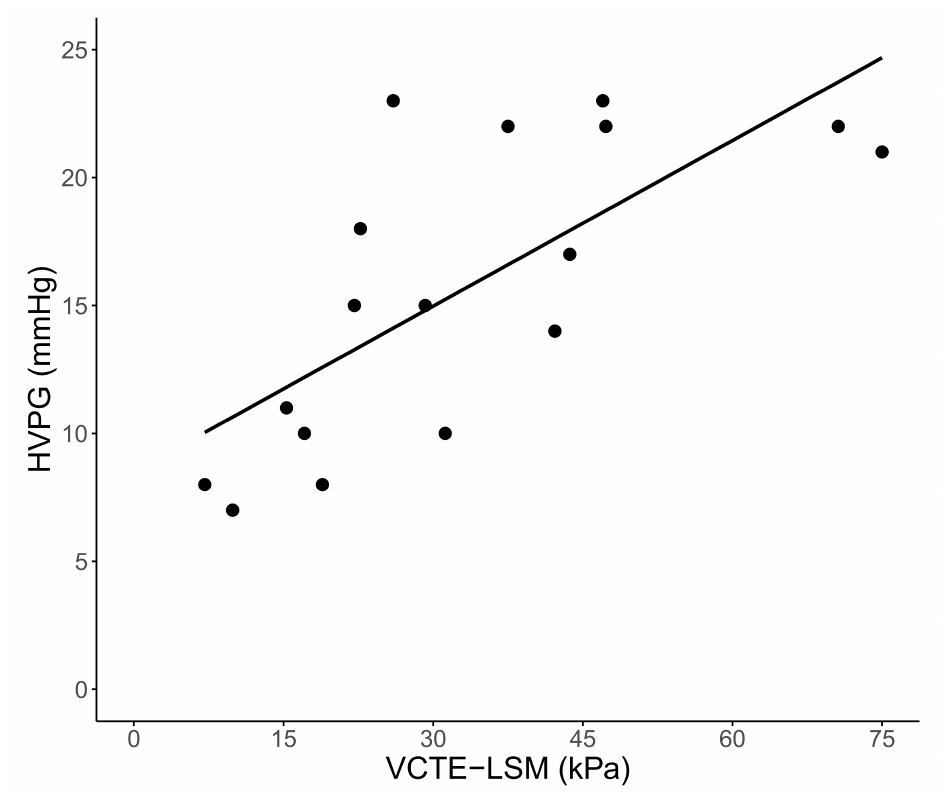
Figure 1. Correlation of the hepatic venous pressure gradient (HVPG) and liver stiffness measurement (LSM) attained by vibration-controlled transient elastography (VCTE) ( n = 17, ρ = 0.725, p <